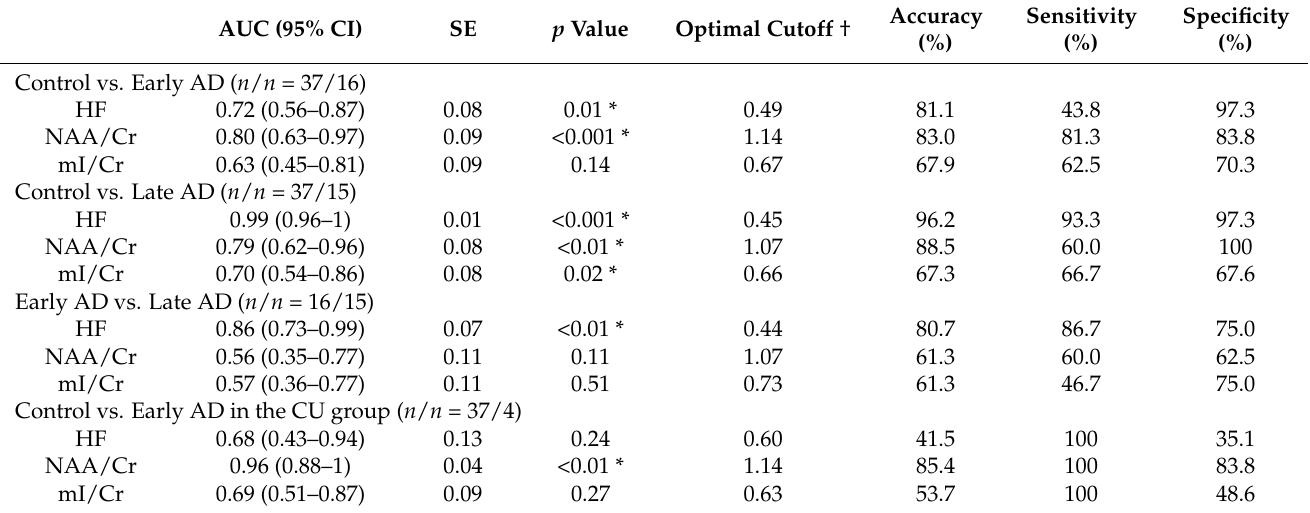
Table 3. Performance of metabolite ratios in classification among